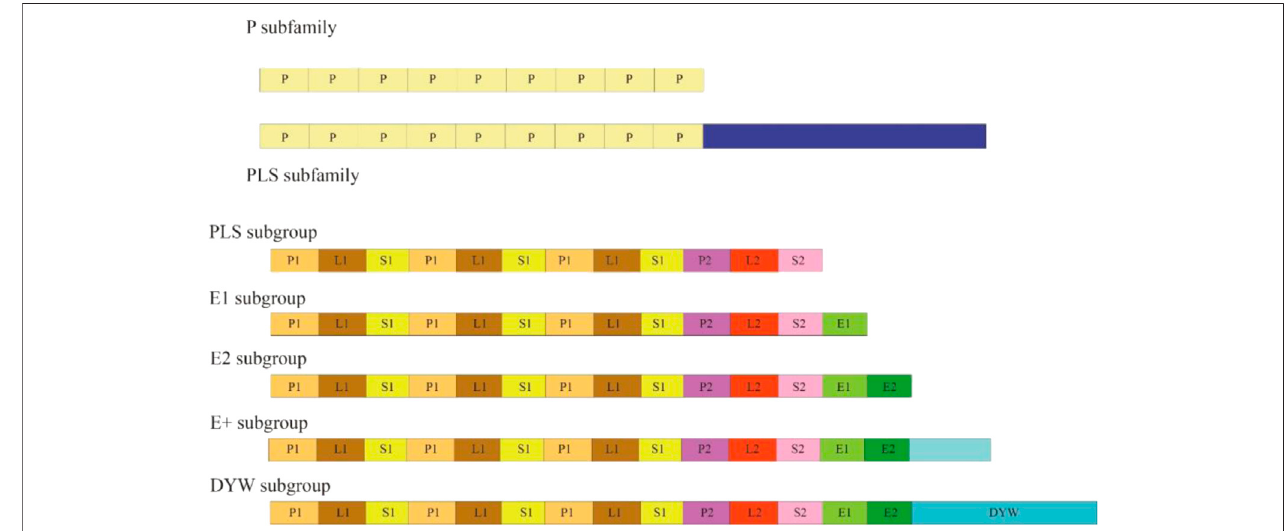
FIGURE 1 | The architecture of different PPR subfamilies and